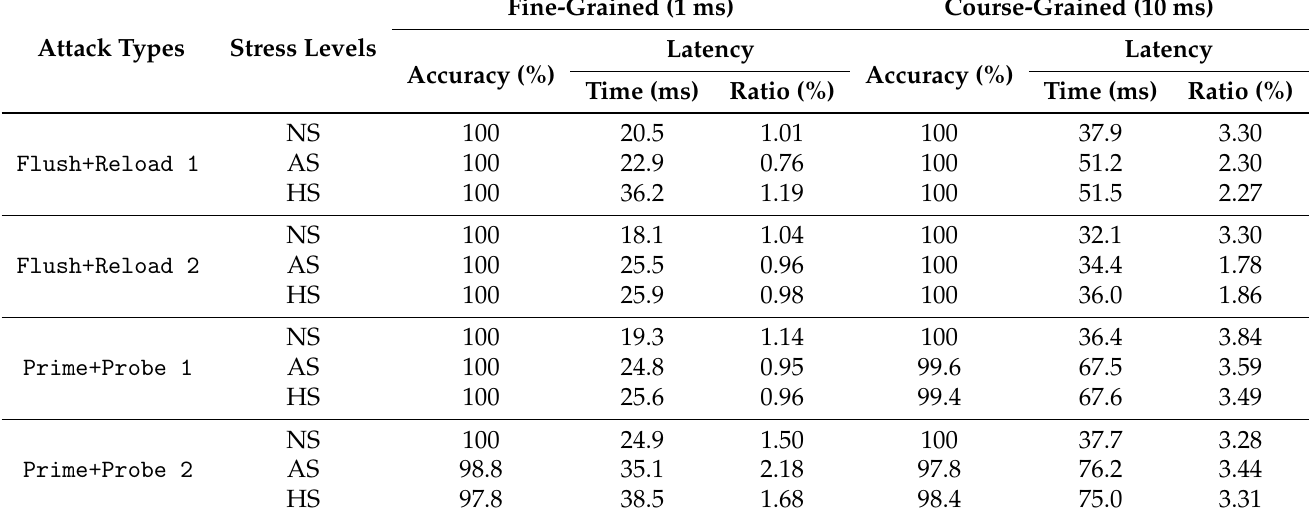
Table 3. Detection accuracy and latency according to the sampling granularity.